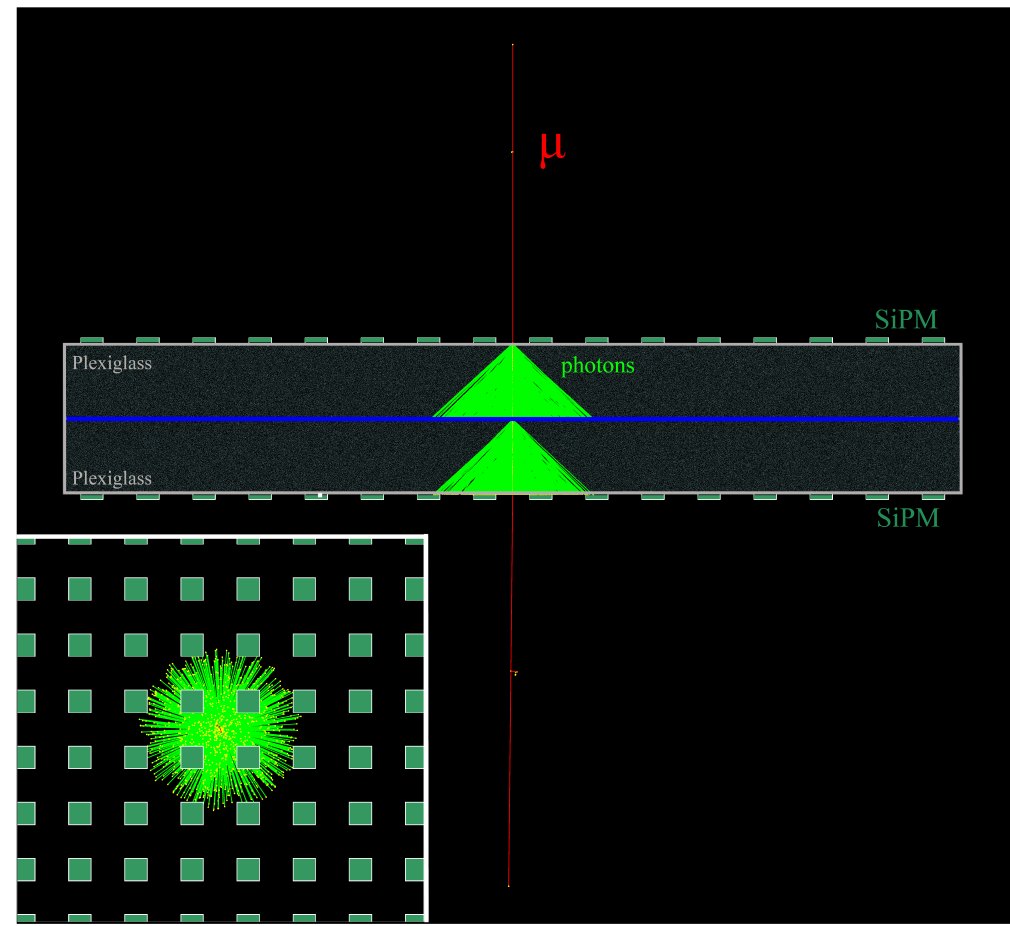
Figure 1. Side view of a muon with kinetic energy 10 2 GeV simulated in Geant4. In this simulation, the radiator material is Plexiglass; the size of each tile (biggest horizontal rectangles) is 20 × 240 × 240 mm 3 ; the external faces are equipped with a regular array of 16 × 16 silicon photo-multipliers (SiPMs), with size 6 × 6 mm 2 (little green rectangles). In the box on the left bottom corner is a front view detail. The yellow dots represent the points at which each Cherenkov (neon green) hits the exit surface of the second